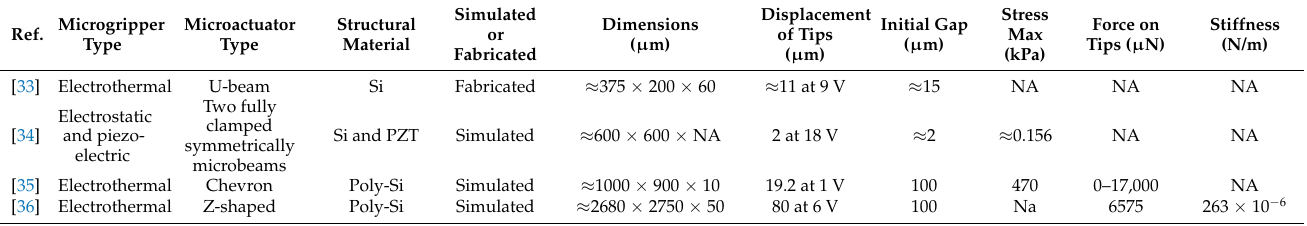
Table 2. State of the art of recent microgrippers, their actuators, and fundamental